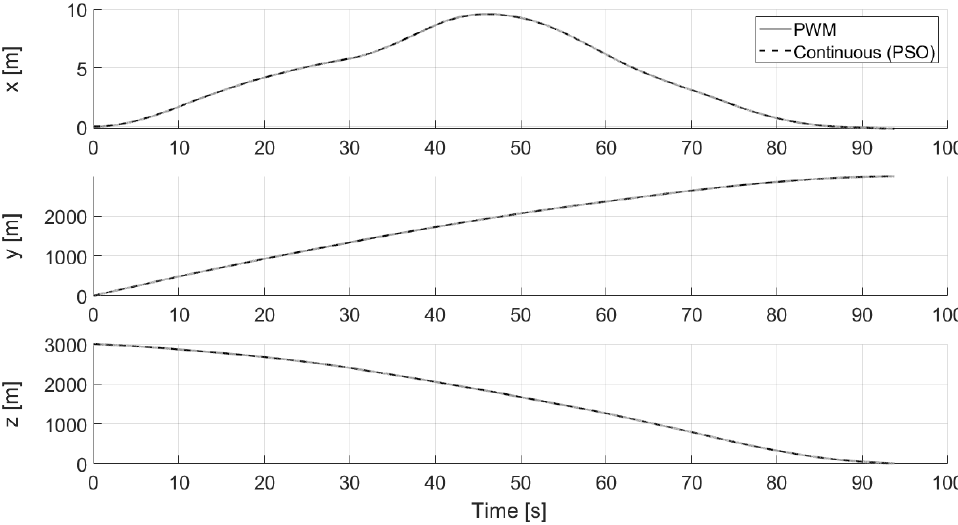
Figure 14. Time-history of position with 10 successive